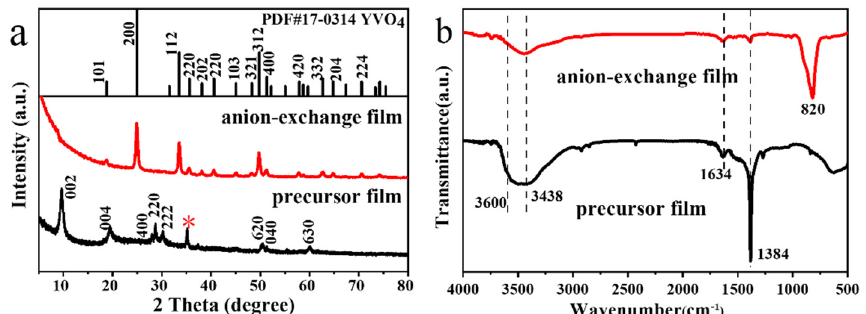
Figure 1. XRD patterns ( a ), FT-IR spectra ( b ) of the precursor film and anion-exchange film. The diffraction peaks of ITO glass were marked with *. diffraction peaks of ITO glass were marked with